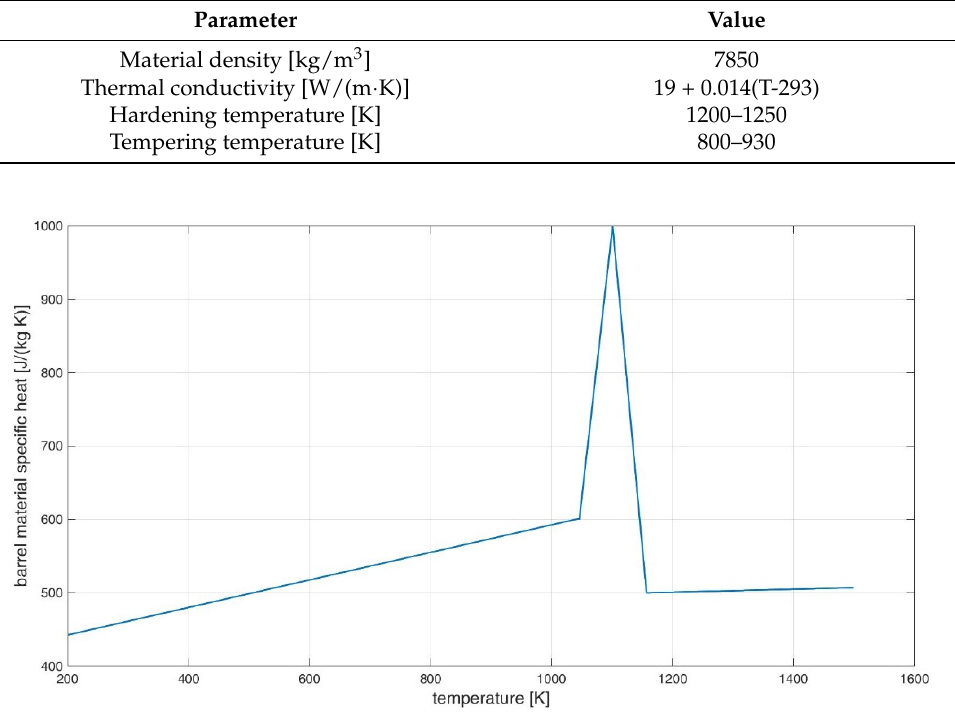
( b ) Figure 13. Ballistic curves (as function of time), ( a )—projectile velocity, ( b )—propellant gas pressure. Moreover, the barrel resistance pressure (defined as the resistant force divided by the barrel cross-section area) as the function of projectile displacement was estimated and is presented in Figure 14. Two important extrema of considered pressure can be noticed